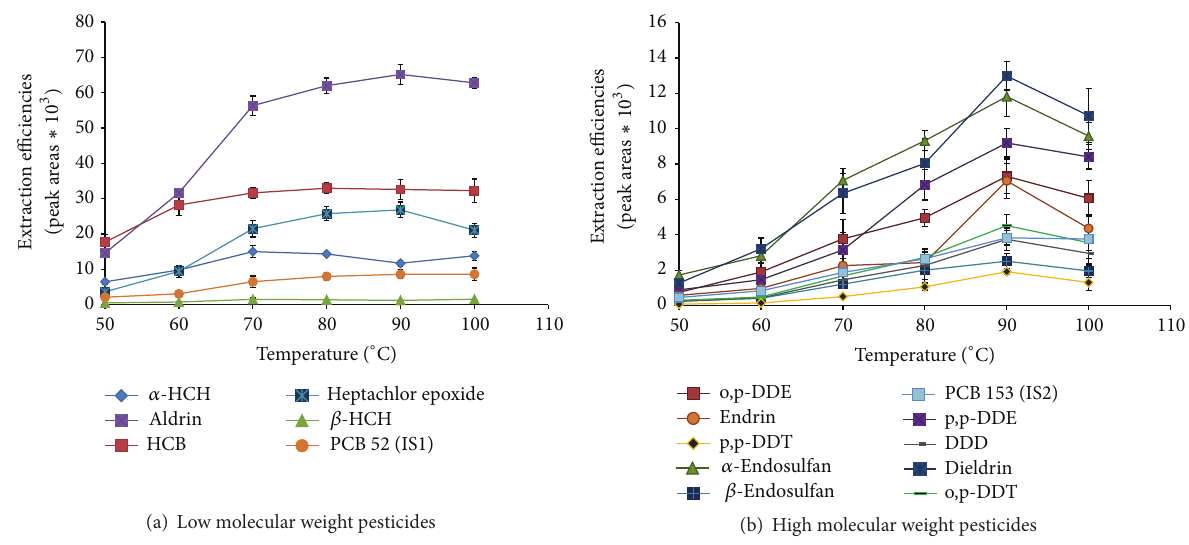
Figure 2: Extraction efficiencies of 14 selected organochlorine pesticides from 50ng g −1 spiked plant root samples, at various temperatures.